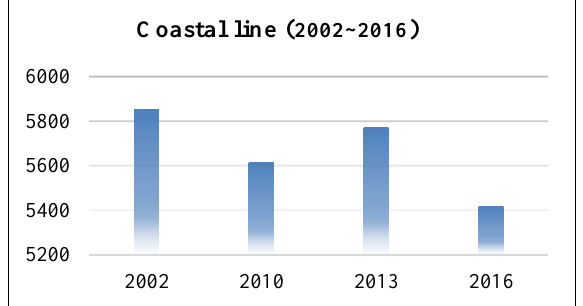
Figure 5. the coastal line change (2002~2016)